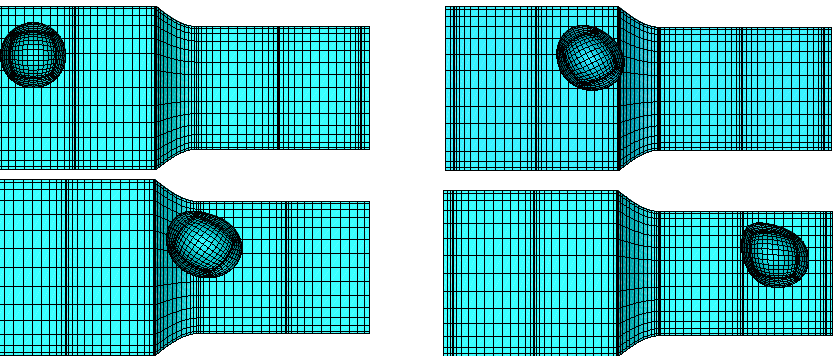
Figure 3. Lateral migration of a Skalak capsule with Ca = 0.1, C = 1, λ = 1, a / (cid:96) = 0.8 and initial position z 0 c / (cid:96) = 0.8 moving inside the constriction. Row-wise, the capsule centroid is x c / (cid:96) = 4, − −